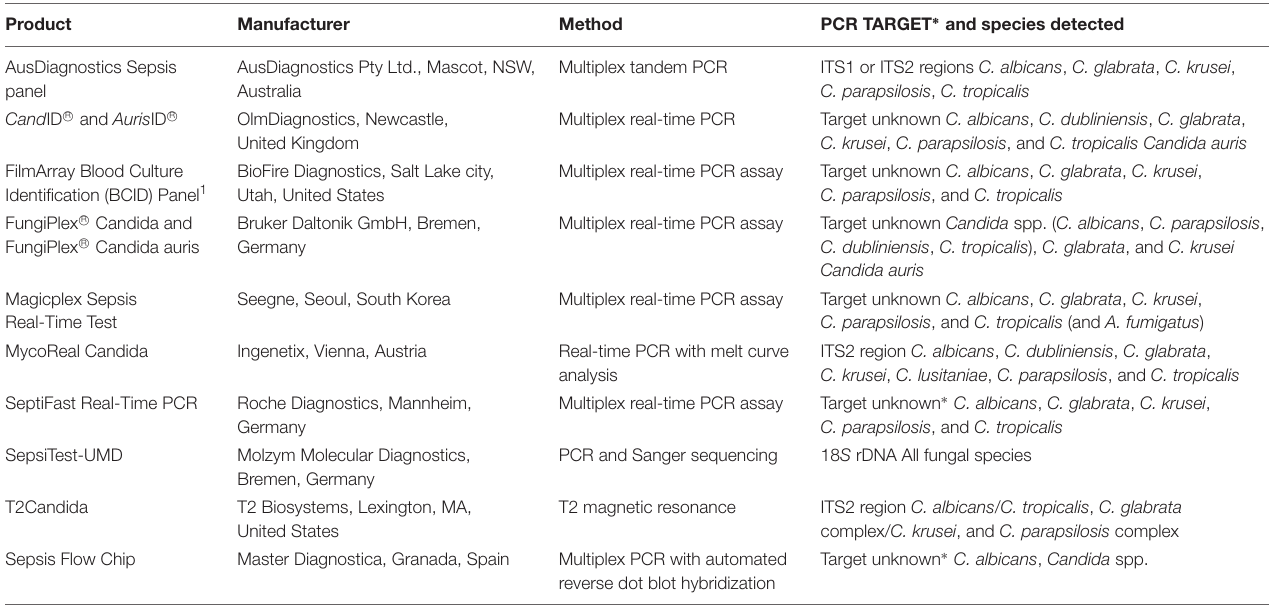
TABLE 2 | List of commercially available PCR-based assays for detection of Candida spp.